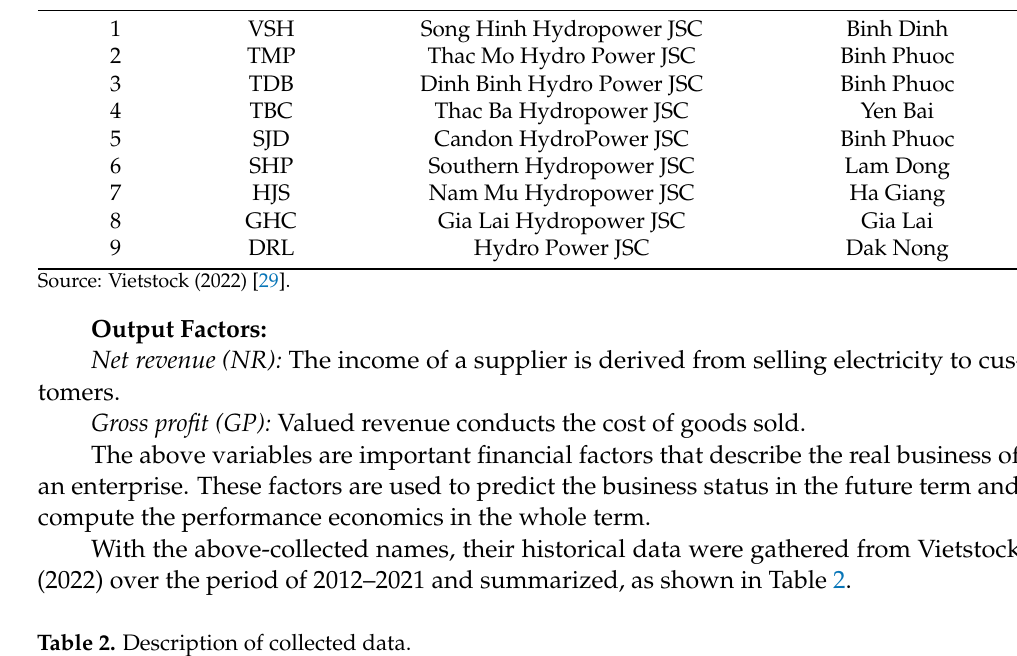
Table 2. Description of collected